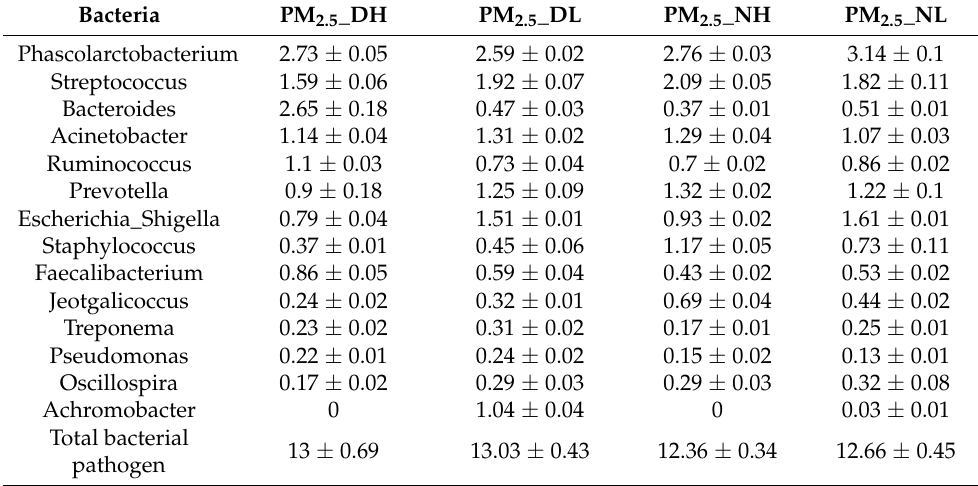
Table 4. The relative abundance of potential pathogenic bacteria in PM 2.5 samples.